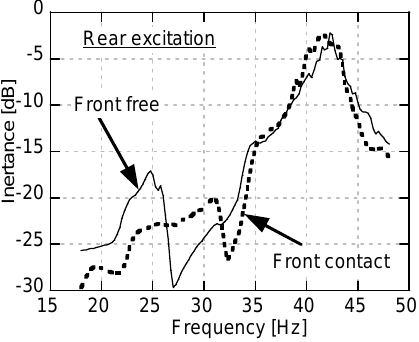
Fig. 3. Inertance of measurement point P on the handlebars, lateral direction ( y )